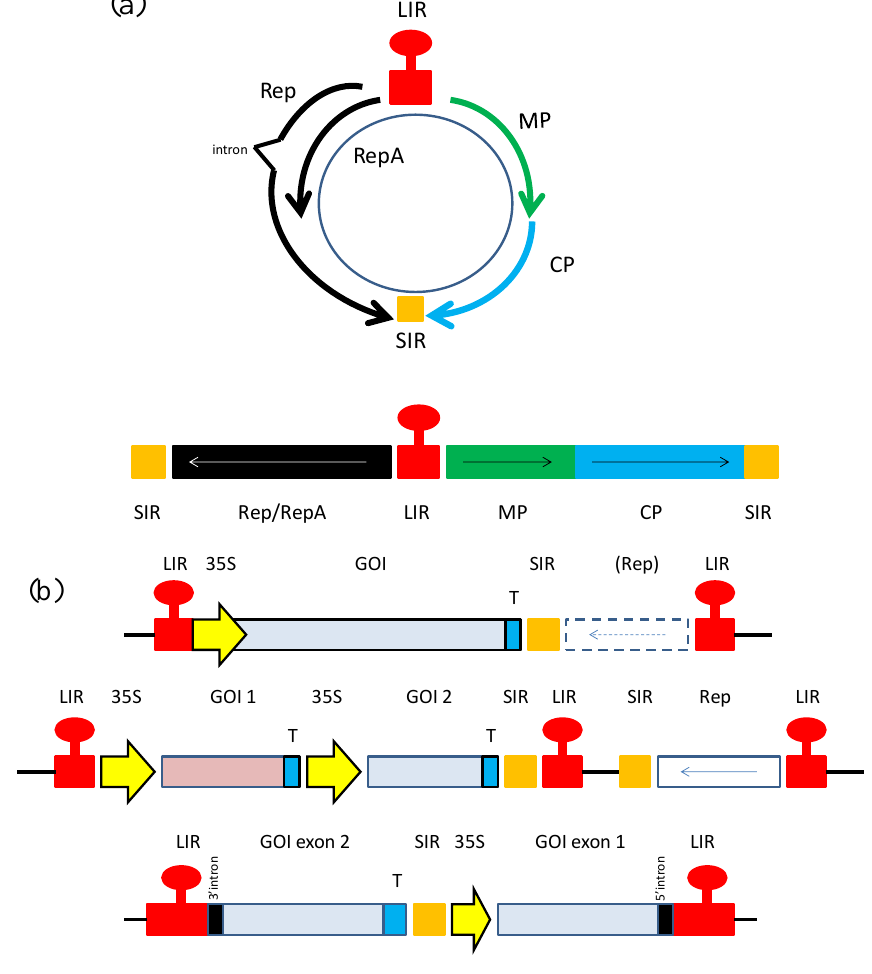
Figure 1. ( a ) Genomic organization of geminiviruses. An example of a mastrevirus is provided. Top; circular version, bottom; linearized version of genome. MP; movement protein, CP; coat protein, LIR and SIR; long and short intergenic regions; ( b ). Geminivirus expression constructs of past and present. Schematic representations of expression vector constructs based on geminiviruses. Top; example of an earlier expression vector. Middle; vector for co-expression of two different proteins, or complex multimeric protein such as monoclonal antibodies. Bottom; foreign gene is expressed in the form of two exons, and protein expression can only take place upon intron processing. In this case, Rep is expressed from an additional construct. GOI; gene of interest, 35S; 35S CaMV promoter, T; terminator. Hatched box; Rep gene could be present in cis in this construct, or expressed in trans from another construct. (middle construct sourced from [15], bottom construct sourced from